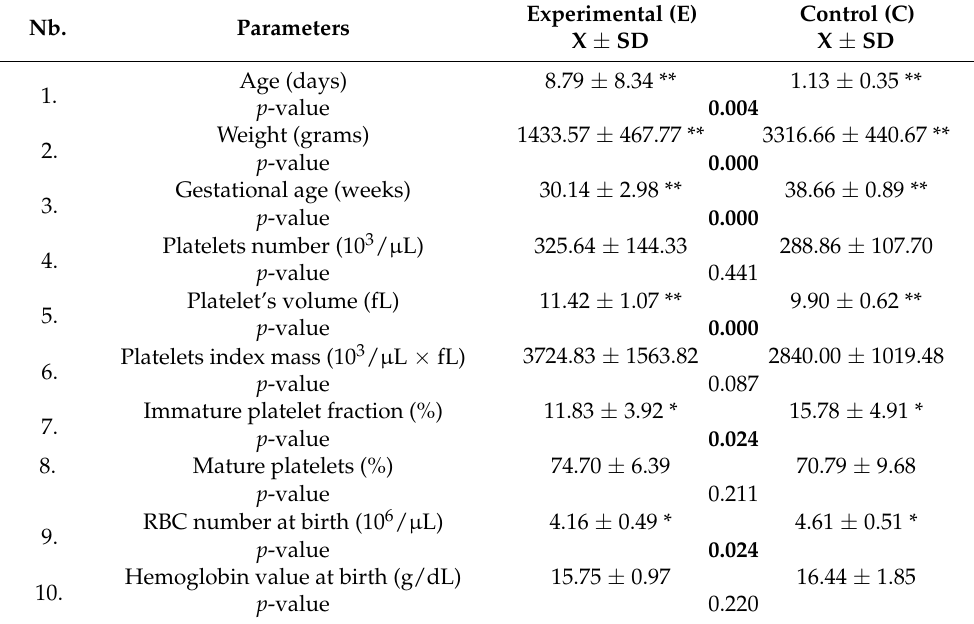
Table 1. Clinicopathological aspects and platelet parameters in preterm newborns (experimental) and healthy full-term newborns (control) cases.